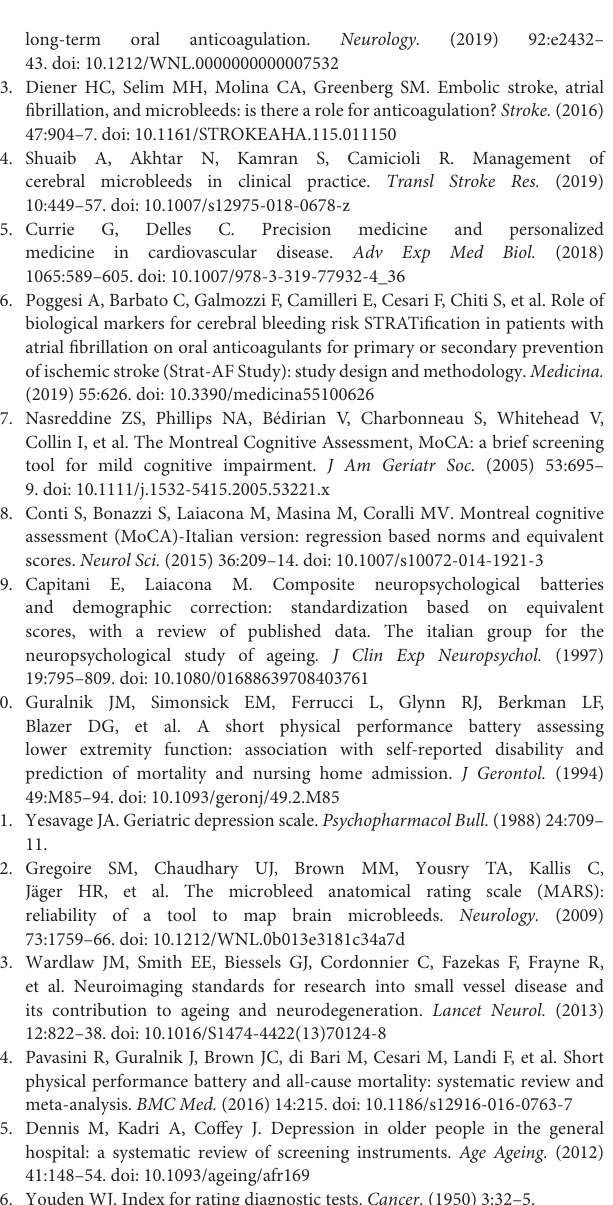
Supplementary Table 9 | Weights of individual items, Youden index, cut-off, sensitivity, and specificity for all best combinations of re-weighted CHA 2 DS 2 -VASc with the addition of MoCA, SPPB, and GDS in relation to non-lacunar infarcts (Phase 3). Supplementary Table 10 | Weights of individual items, Youden index, cut-off, sensitivity, and specificity for all best combinations of re-weighted HAS–BLED with the addition of MoCA in relation to CMBs (Phase 3). Supplementary Table 11 | Weights of individual items, Youden index, cut-off, sensitivity, and specificity for all best combinations of re-weighted HAS–BLED with the addition of MoCA in relation to lacunar infarcts (Phase 3). Supplementary Table 12 | Weights of individual items, Youden index, cut-off, sensitivity, and specificity for all best combinations of re-weighted HAS–BLED with the addition of MoCA in relation to non-lacunar infarcts (Phase